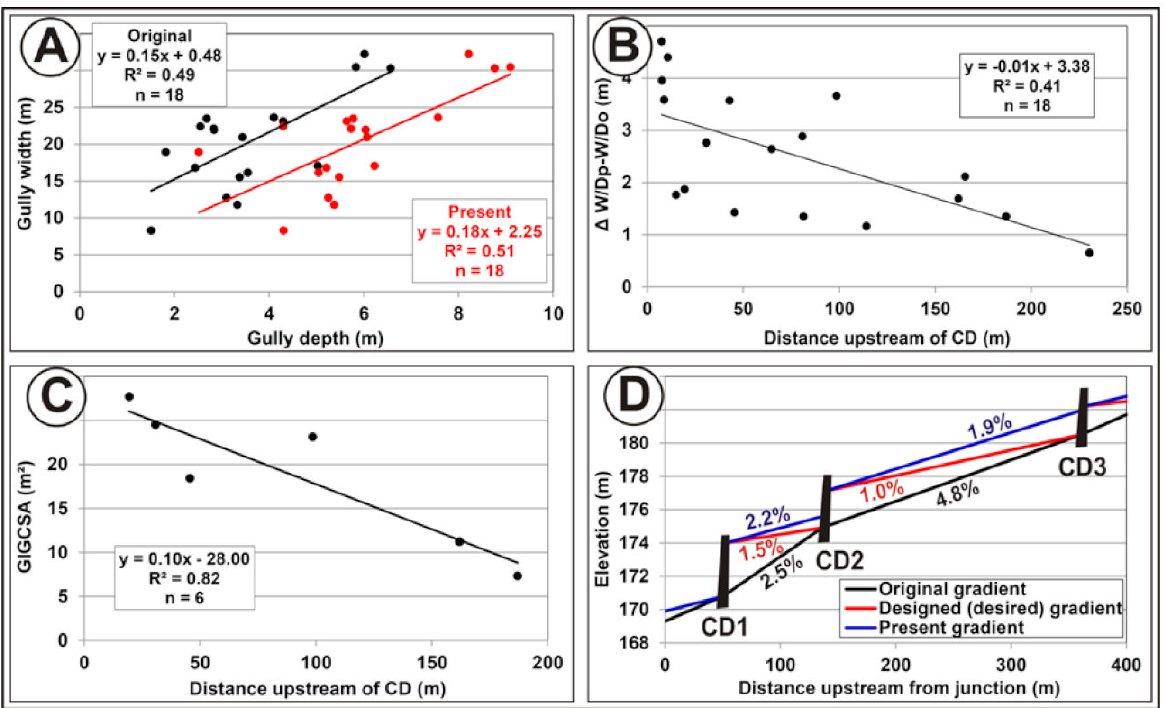
Figure 8. Changes in gully morphology after implementing conservation measures: ( A ) relationship between GD and GW at present and in 1974, ( B ) relationship of the difference between present and original W/D ratios versus the distance upstream of check dams, ( C ) rate of gully infilling expressed by growth of the infilled gully cross section area (GIGCSA) to distance upstream of check dams (CDs) in the Gologofta gully, ( D ) longitudinal profile along a reach of 361 m from the Gologofta gully, upstream of the junction with the Balica